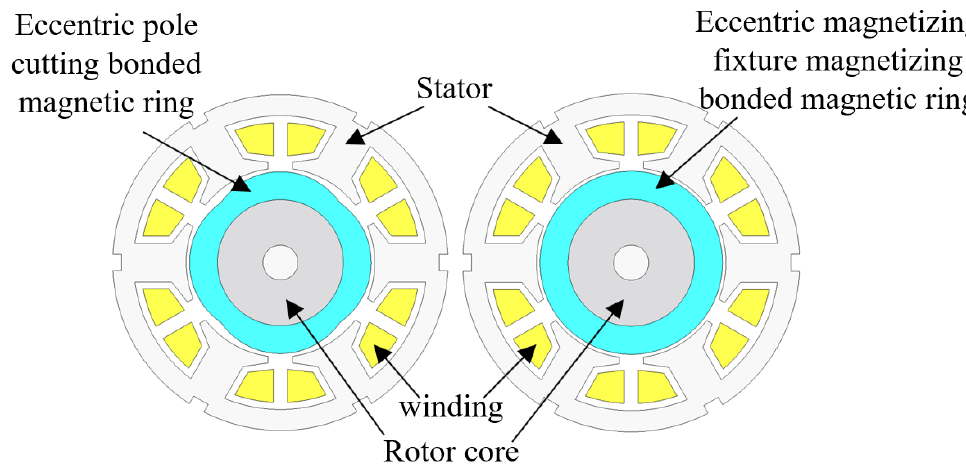
Figure 8. Application of two kinds of bonded magnetic rings in motor.